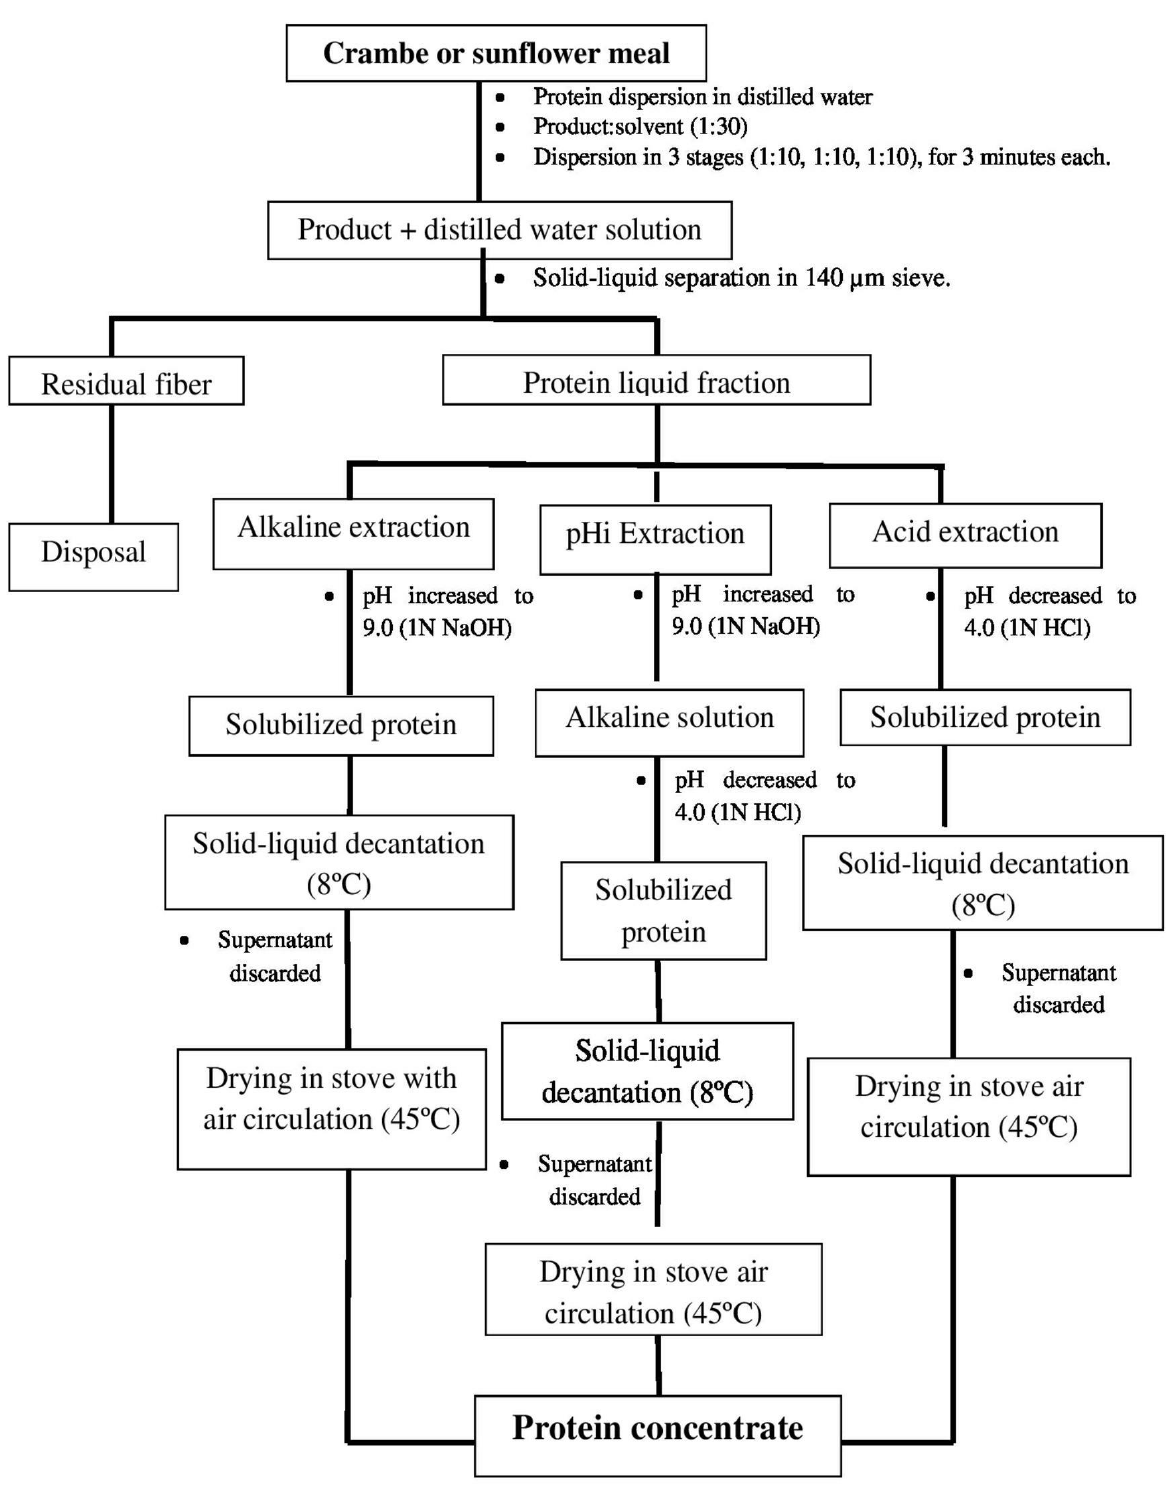
Figure 1 - Protein concentration methods for crambe and sunflower meals: alkaline extraction, extraction by isoelectric pH, and acid